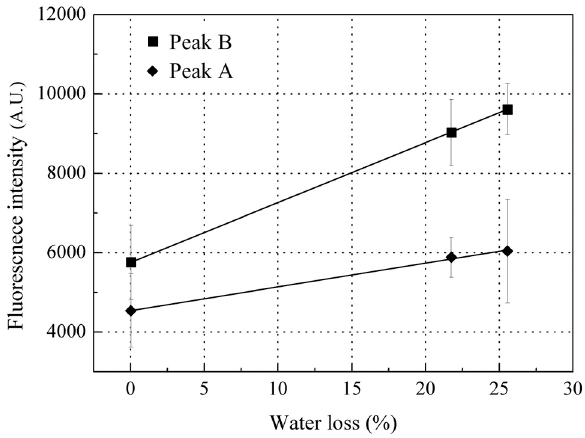
Figure 7. Change in Peak B and A fluorescence intensities with water loss. Values shown are the means of 3 replicates with standard deviation bars.